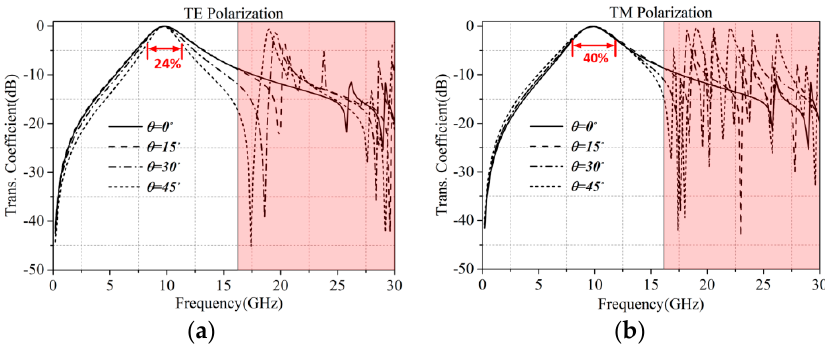
Figure 3. Transmission coefficient characteristics for oblique incidences on the resonant complementary